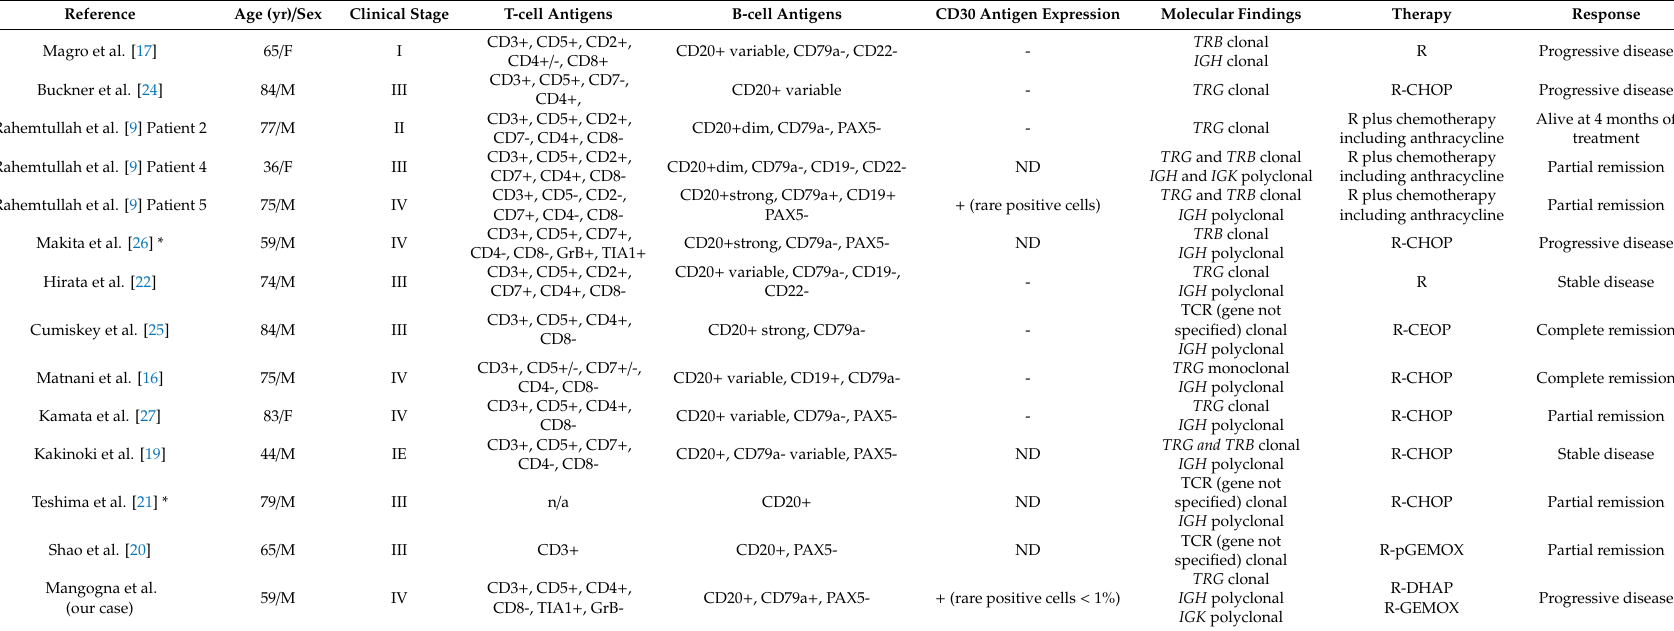
Table 1. Published cases of CD20-positive peripheral T-cell lymphoma, not otherwise specified (PTCL-NOS) treated with rituximab alone or with chemotherapy.